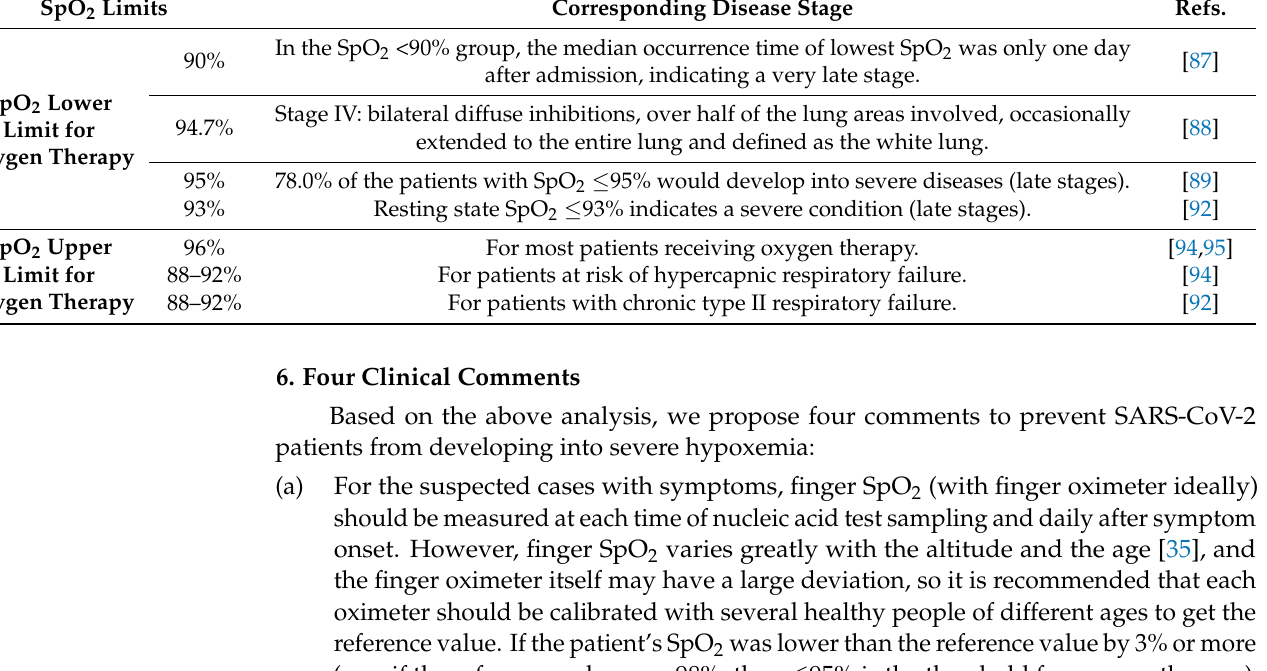
Table 3. Blood oxygen saturation (SpO 2 ) lower limit and upper limit for oxygen therapy. SpO 2 Limits Corresponding Disease Stage